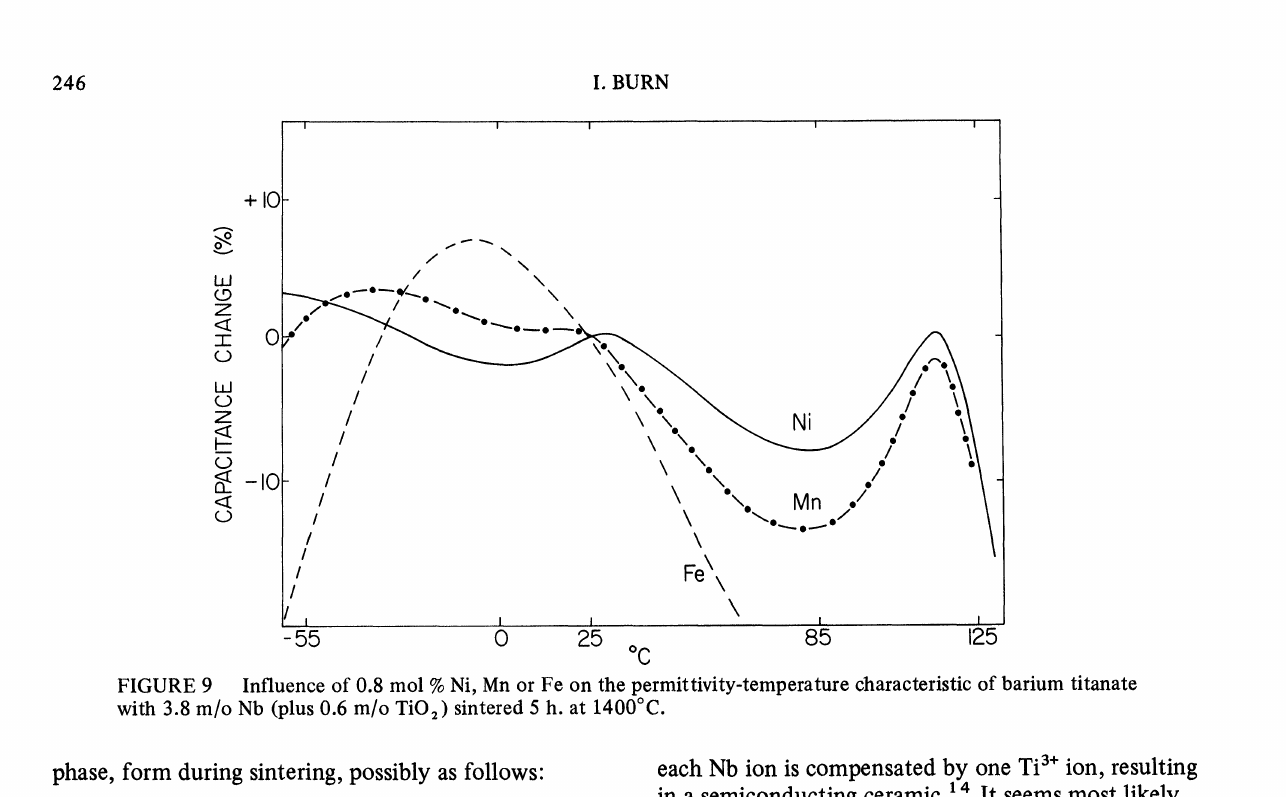
FIGURE 9 Influence of 0.8 mol N Ni, Nn or Fe on the permittivity-temperature characteristic of barium titanate with 3.8 m/o Nb (plus 0.6 m/o TiO) sintered 5 h. at